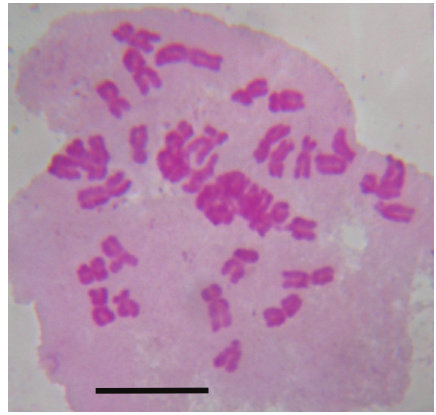
Figure 6. Knautia dinarica (Murb.) Borbás subsp. silana (Grande) Ehrend., 2 n = 40. Scale bar: 10